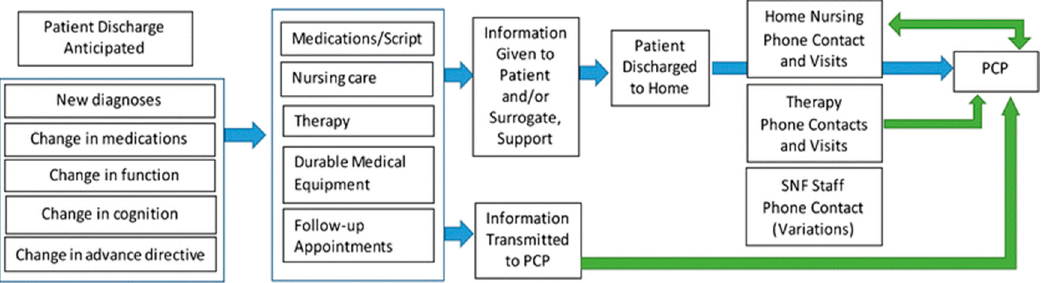
Figure 1. Consensus panel-determined work-flow for a patient transitioning from the skilled nursing facility (SNF) to home.